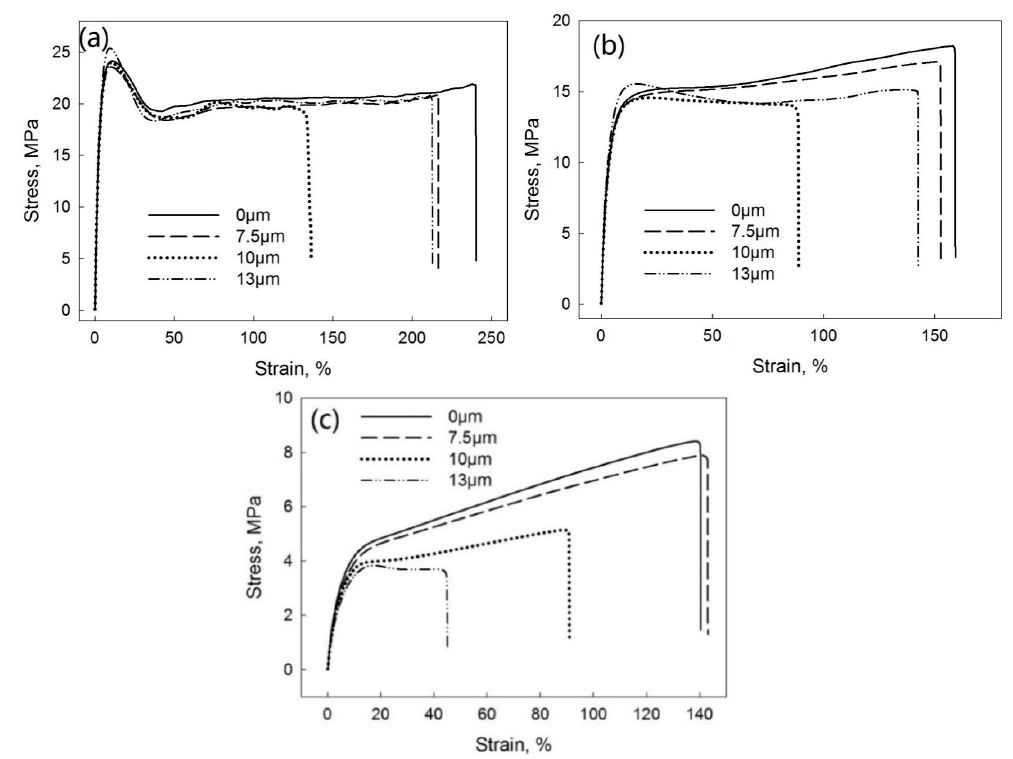
Figure 12. Stress–strain curves of PP/EPDM 75/25 ( a ), 50/50 ( b ), and 25/75 ( c ) blends prepared at different ultrasonic amplitudes by the TS method.